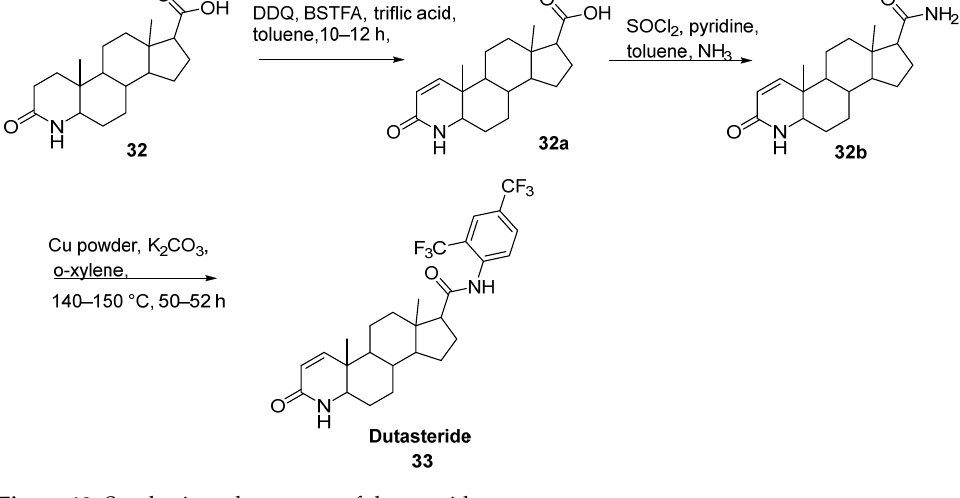
Figure 18. Synthesis and structure of